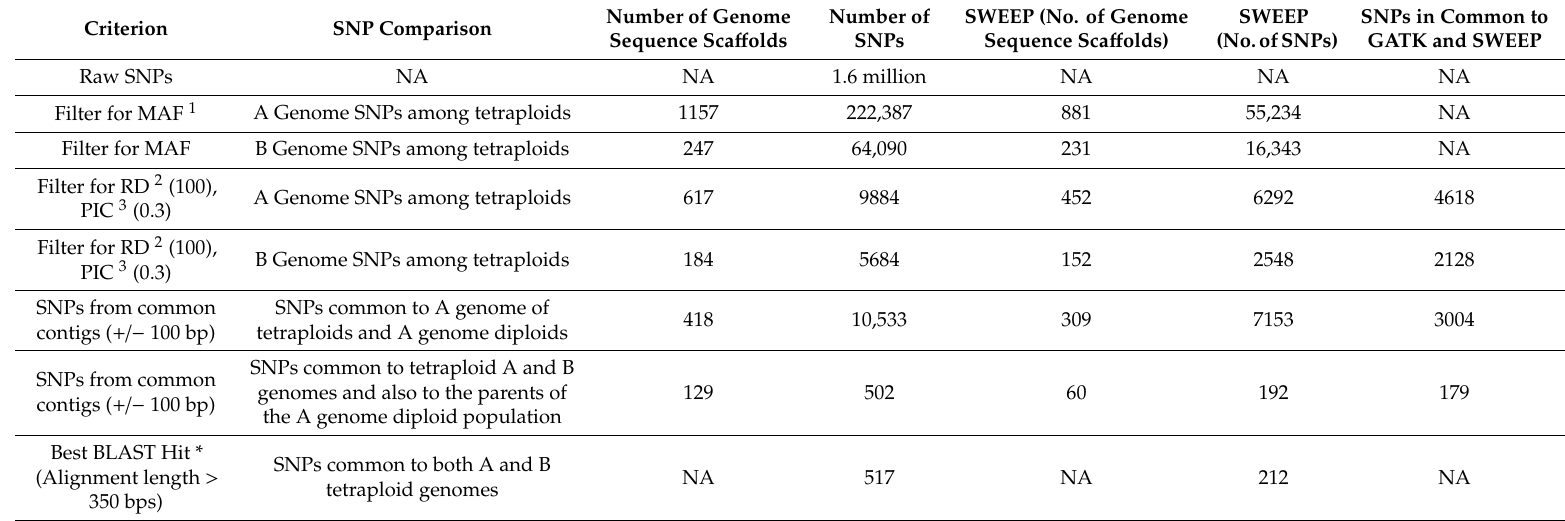
Table 2. Summary of SNPs identified from the SNP identification pipeline for target